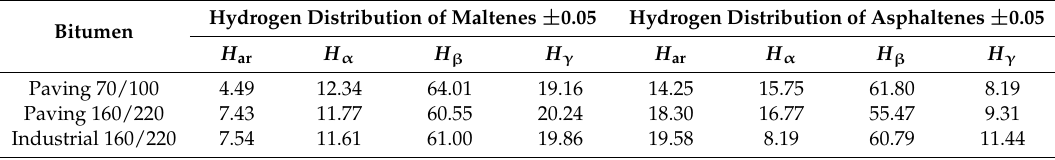
Figure 5. The 1 H-NMR spectra of Paving 160/220 bitumen in CCl 4 : ( a ) neat bitumen; ( b ) maltene fraction; and ( c ) asphaltene fraction. Table 4. Fractional proton distribution of the maltene and asphaltene fractions obtained from